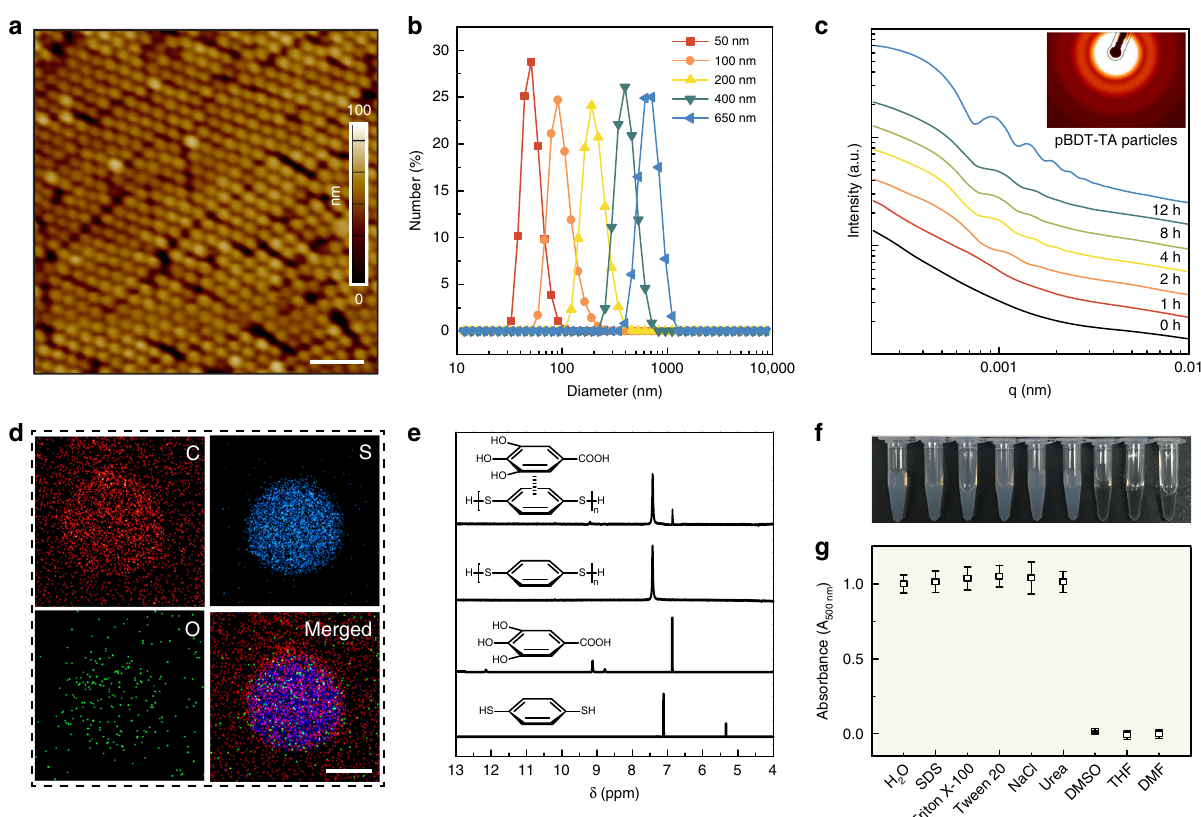
Fig. 2 Assembly and disassembly of supramolecular pBDT – polyphenol particles. a AFM image of 100 nm pBDT – TA particles prepared from a mixture of 0.5 mg mL − 1 BDT and 0.5 mg mL − 1 TA. Scale bar is 500 nm. b Dynamic light-scattering data of the pBDT – TA particles with different sizes. c In situ growth of the pBDT – TA particles, as measured by SAXS. Inset: SAXS pattern of the pBDT – TA particles obtained after 12 h of reaction, post-puri fi cation. d EDX elemental mapping of the pBDT – TA particles. Scale bar is 50 nm. e 1 H NMR spectra of the different components in the complexes. f , g Photograph and turbidity results of the pBDT – TA particles (100 nm) in different media. The error bars represent standard deviations ( n =